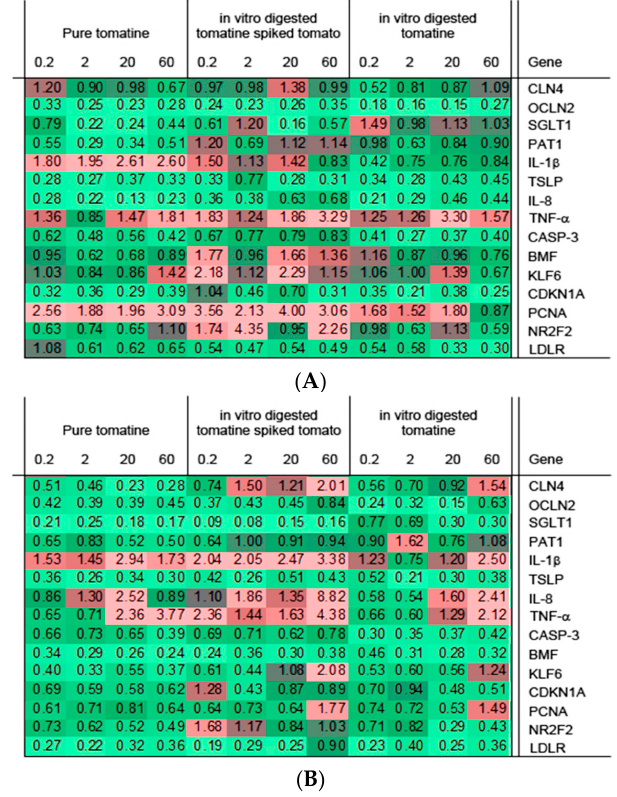
Figure 5. Relative gene expressions (RGE) resulted after 1 h ( A ) and 4 h ( B ) of exposure to pure tomatine, in vitro digested tomatine spiked to tomato matrix and in vitro digested